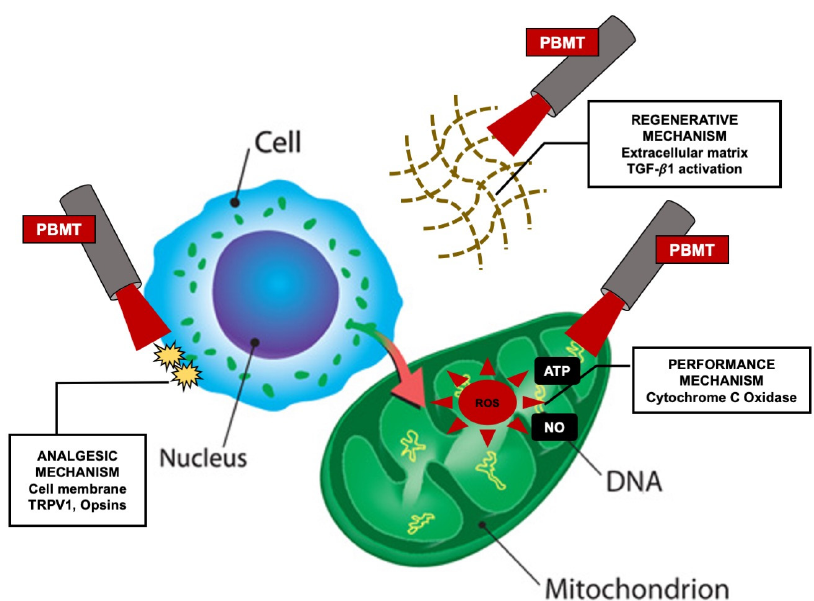
Figure 2. Modified schematic description of the three discrete PBM mechanisms of action [11] Abbreviations: TRPV1, transient receptor potential cation channel subfamily V member1; TGF- β ,